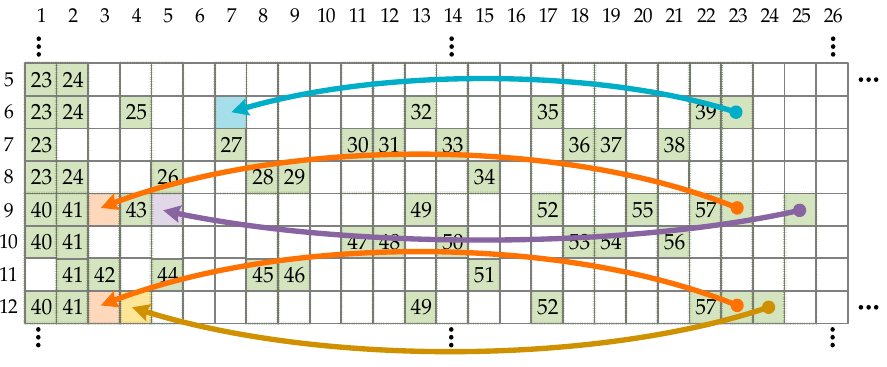
Figure 6. Illustration of processing repositioning for core parity bits related CPMs.